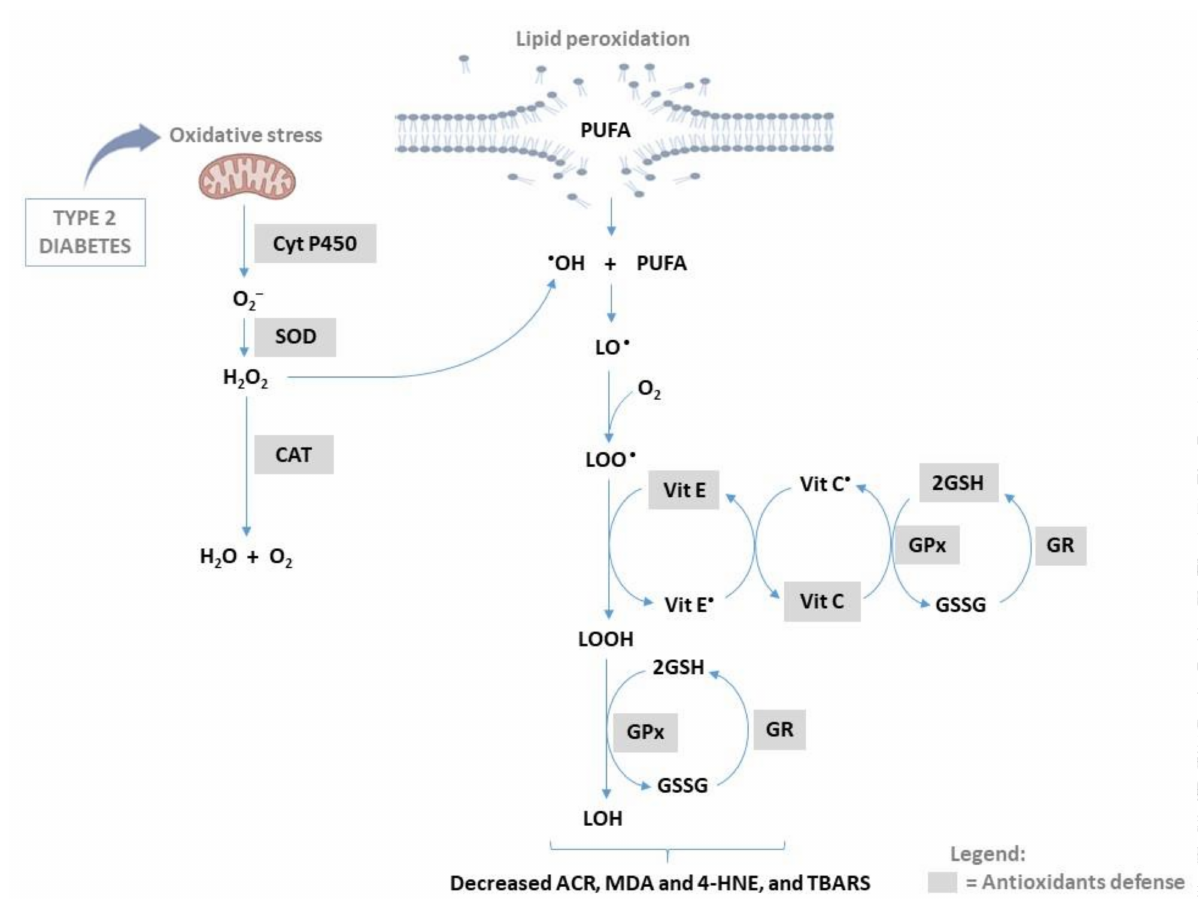
Figure 3. An overview of different antioxidants and their capacity to terminate lipid